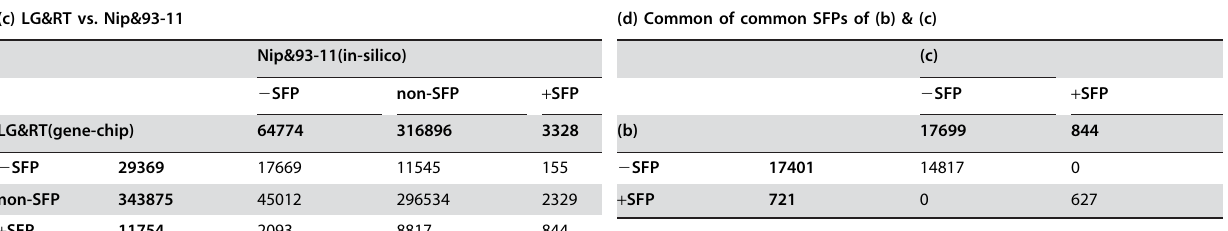
The gene-chip predicted SFPs data for CP&LG, CP&RT and LG&RT have been taken from estimated FDR (delta) of 11.9% (delta=2), 10% (delta=2)and 10% (delta=1.6) respectively. The SFP data for Nip&93-11 have been taken from in-silico analyses(see methods; supplementary Table S3). The table has been generated from 384998 features shared by gene-chip and in-silico analyses. The sign( + / 2 ) indicates direction of polymorphism as explained in Figure-3 and Table S3 legend. CP=Cypress, LG=LaGrue, RT=RT0034 and Nip=Nipponbare.